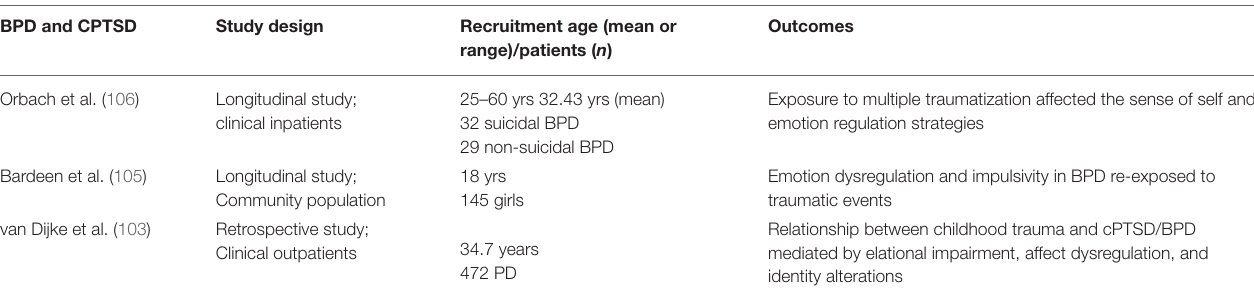
TABLE 4 | Studies on BPD and complex